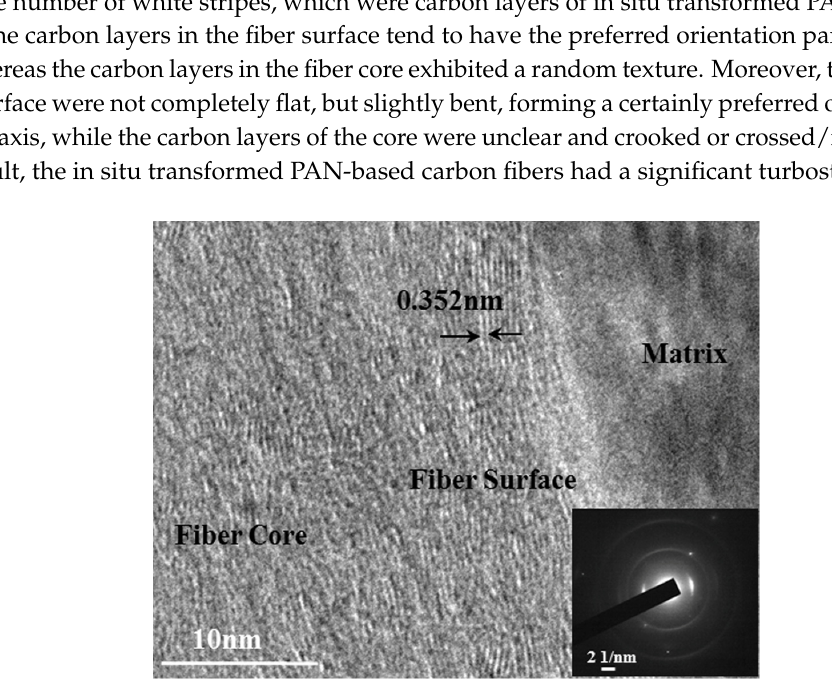
Figure 5. HR-TEM image and diffraction pattern of in situ transformed PAN carbon fibers.